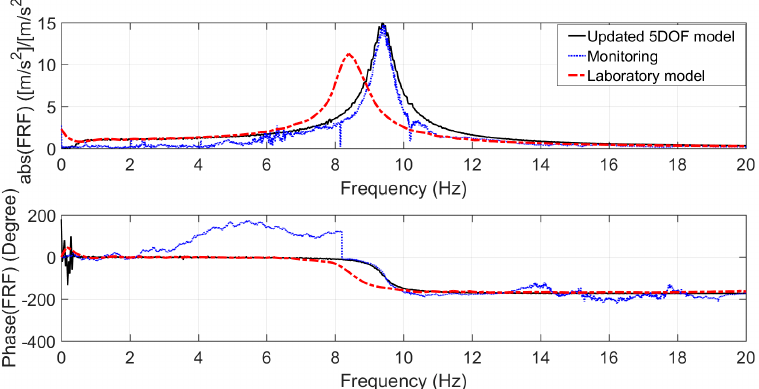
Figure 7. FRF in the vertical direction between the seismic plate and the upper plate obtained from the updated model (black line), and the corresponding FRF obtained from the monitoring (blue dotted line) and the older model (red dashed line).